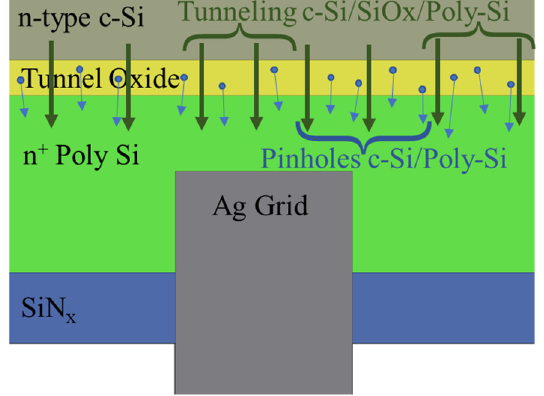
Figure 6. Carrier transportation appearance and formal illustration of tunneling and pinholes phenomenon of the tunnel oxide layer in TOPCon solar cell.